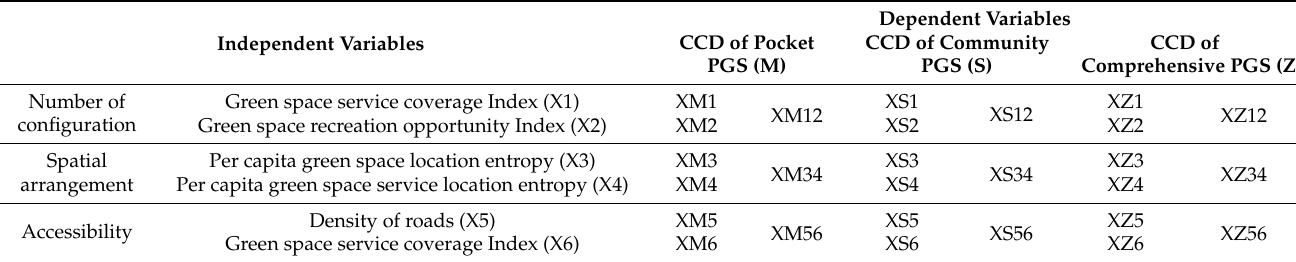
Table 9. Indexes system of 3-scale PGS and coupling coordination degree (CCD).